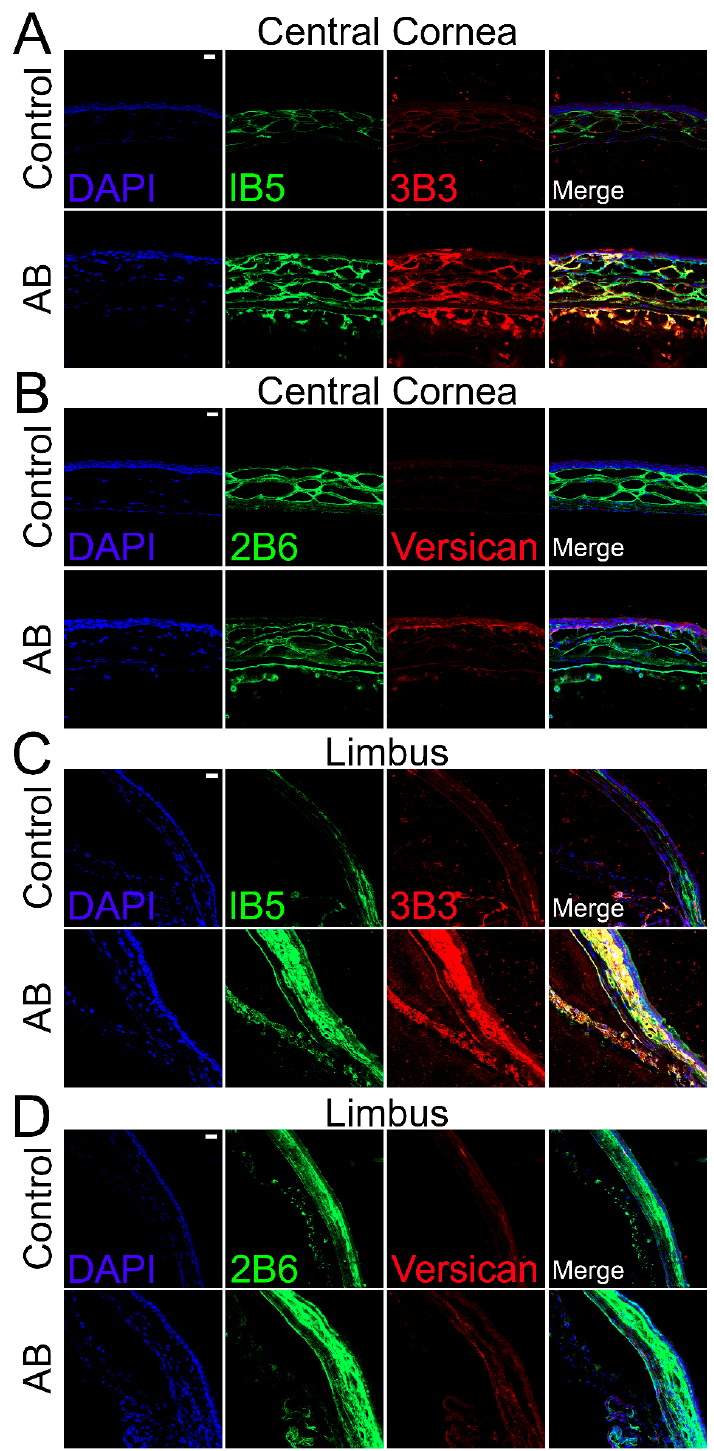
Figure 4. Expression and localization of different CS epitopes and versican in the central cornea and limbal region of mice before and after AB. Mouse corneas were subjected to AB and corneas analyzed after 14 days, with uninjured contralateral corneas used as controls. The central cornea ( A , B ) and the limbal region ( C , D ) were imaged under a confocal microscope. The expression and localization of CS epitopes were analyzed using 1B5 and 3B3 antibodies by immunocytochemistry ( A , C ). The expression and localization of the CS epitope 2B6 and versican were analyzed by immunocytochem- istry ( B , D ). Nuclei were stained with DAPI (blue). Scale bar 20 µ m. Seven corneas were analyzed per experimental group and a representative image